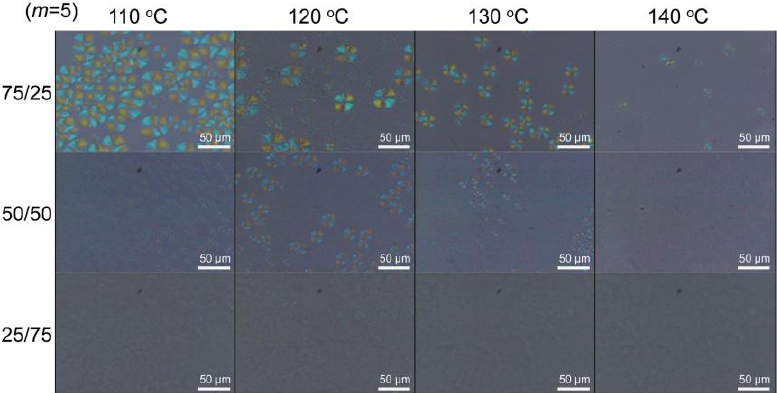
Figure 6. Polarized optical microscope images of the SPN-5scLAO/CLOs 75/25, 50/50 and 25/75 held at a specified temperature for 10 min after melted at 220 °C.